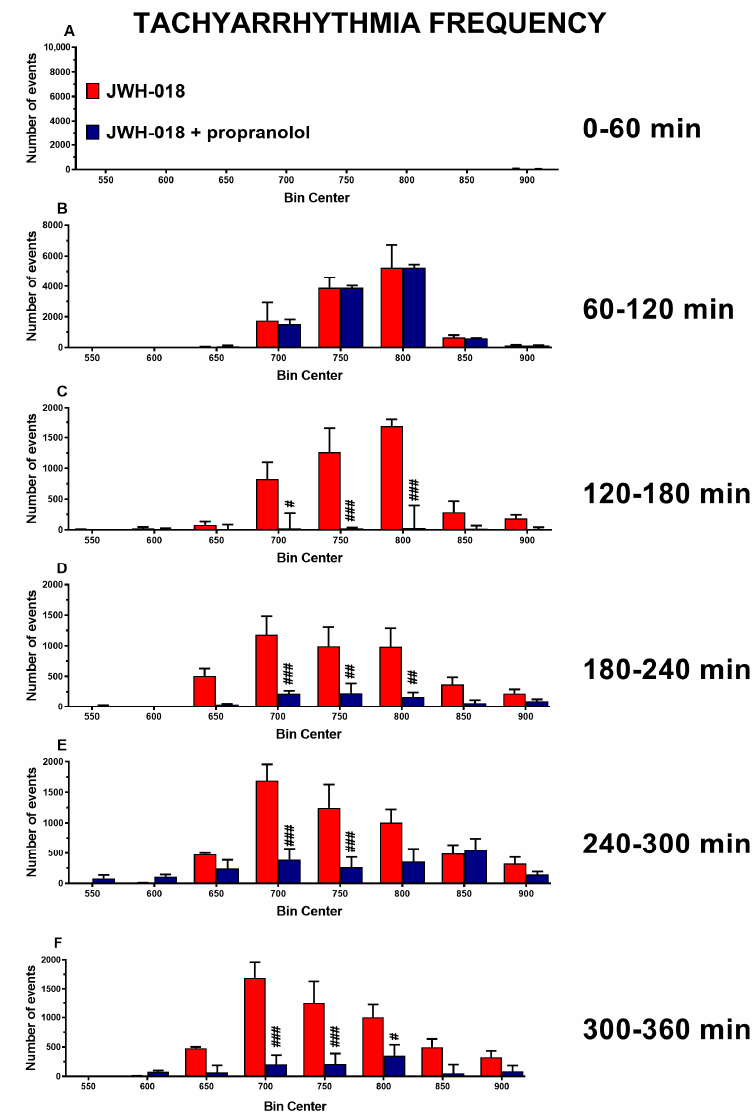
Figure 8. Frequency of tachyarrhythmia episodes between 0–60 ( A ), 60–120 ( B ), 120–180 ( C ), 180–240 ( D ), 240–300 ( E ), and 300–360 ( F ) minutes after administration of JWH-018 (6 mg/kg) or JWH-018 followed by propranolol (2 mg/kg), expressed as number of events per mean heart rate value. Mean ± SEM of eight different evaluations for each group. Statistical analysis was performed by two-way ANOVA followed by Bonferroni’s test for multiple comparisons. # p < 0.05, ## p < 0.01, ### p < 0.001 versus JWH-018 +